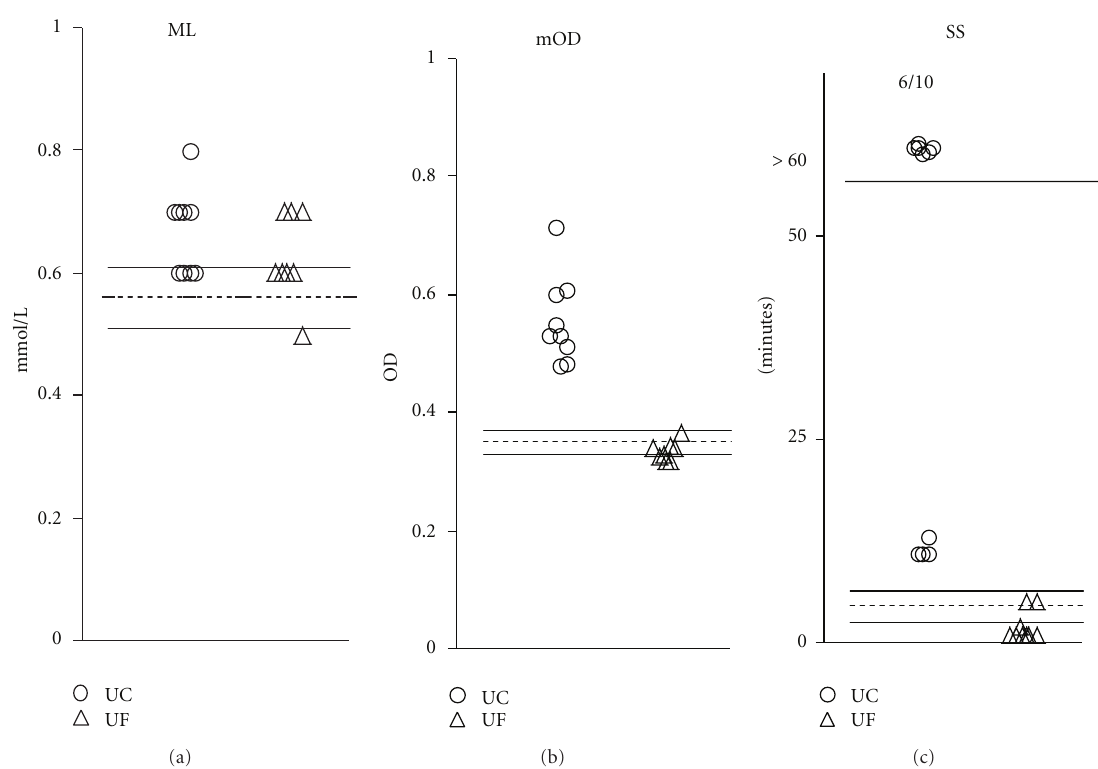
Figure 3: Crystallization parameters (see Figure 2) in urine of controls (UCs), in ultrafiltrate of the same urine (UF), and in control solution (shaded area).